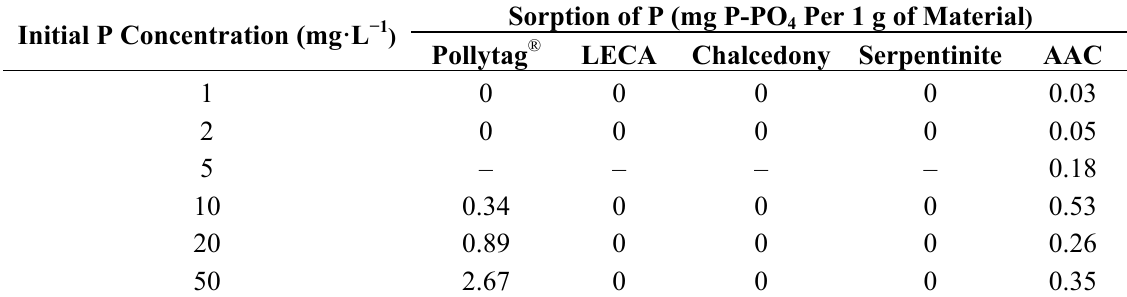
Table 6. Results of the preliminary sorption